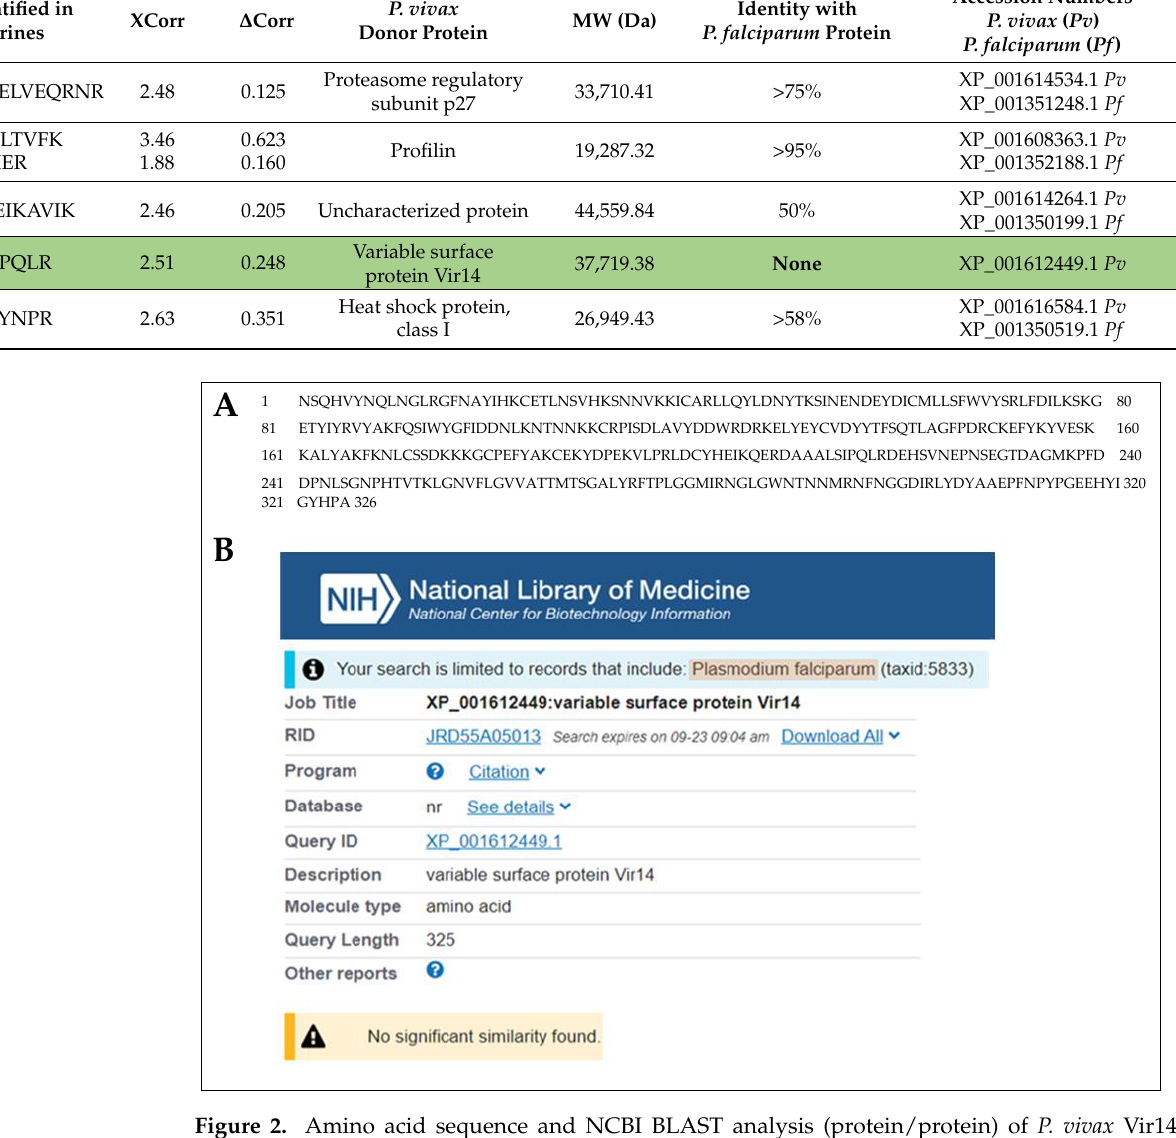
Table 1. Plasmodium vivax peptides identified by mass spectroscopy in urine samples of patients with P. vivax malaria from Brazil. Peptide Identified in